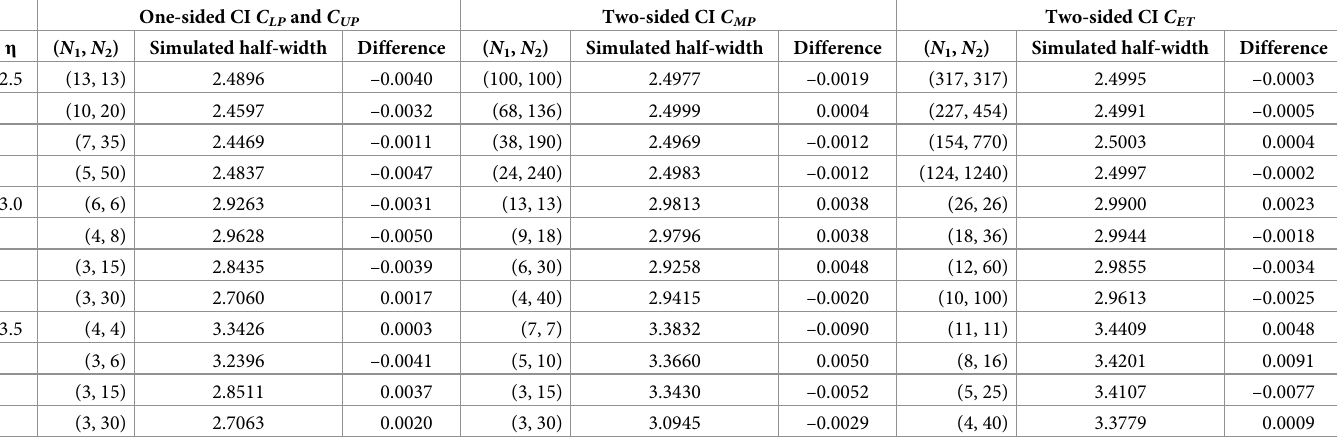
computed sample sizes are presented in Tables 2–7 for the expected half-width and assurance probability, respectively.